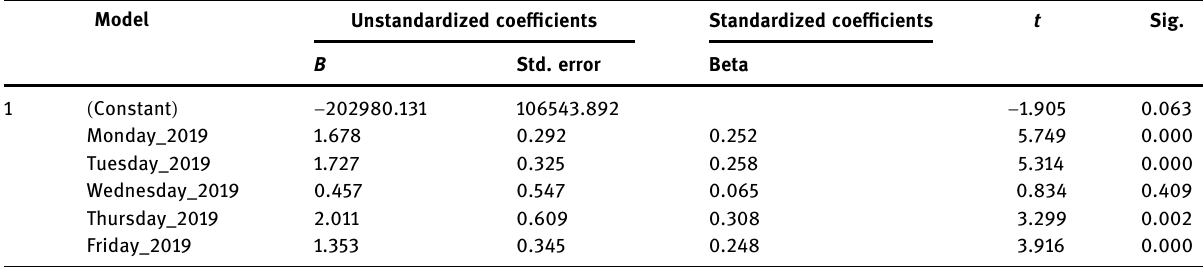
Table 4: Coe ffi cients for weekdays